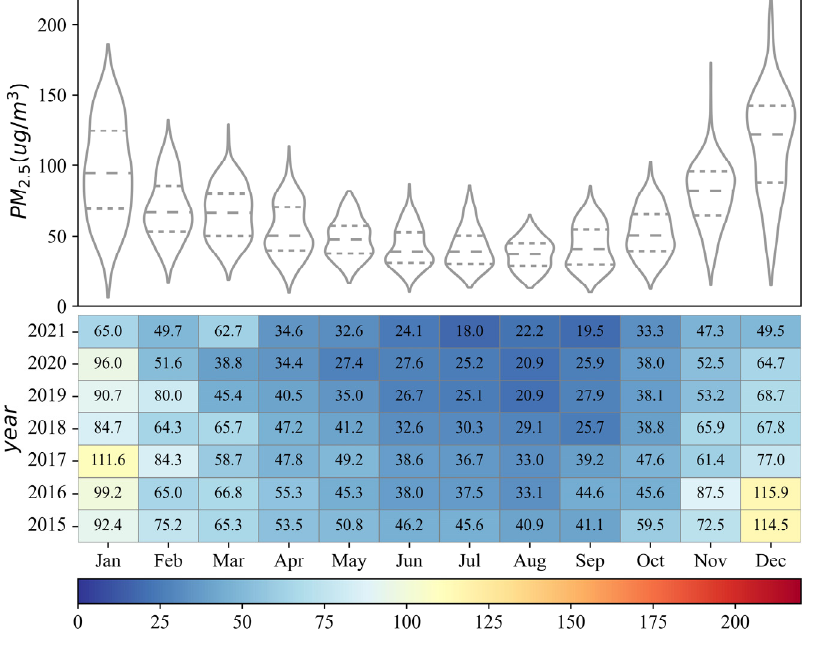
Figure 3. Inter-month variations of PM2.5 concentrations in the Yellow River Basin from 2015 to 2021.